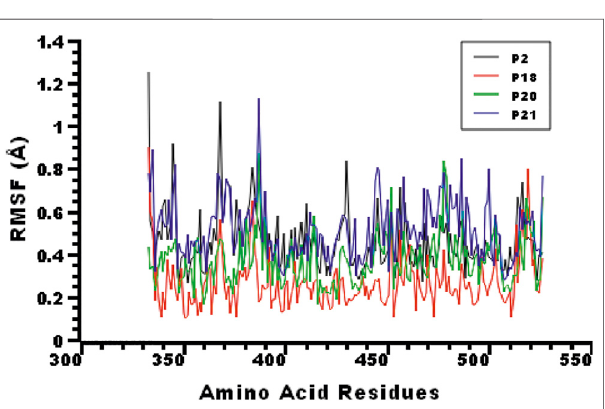
FIGURE 4 | The root mean square fl uctuation (RMSF) of the complexes to analyze the fl exibility of the amino acid residues.